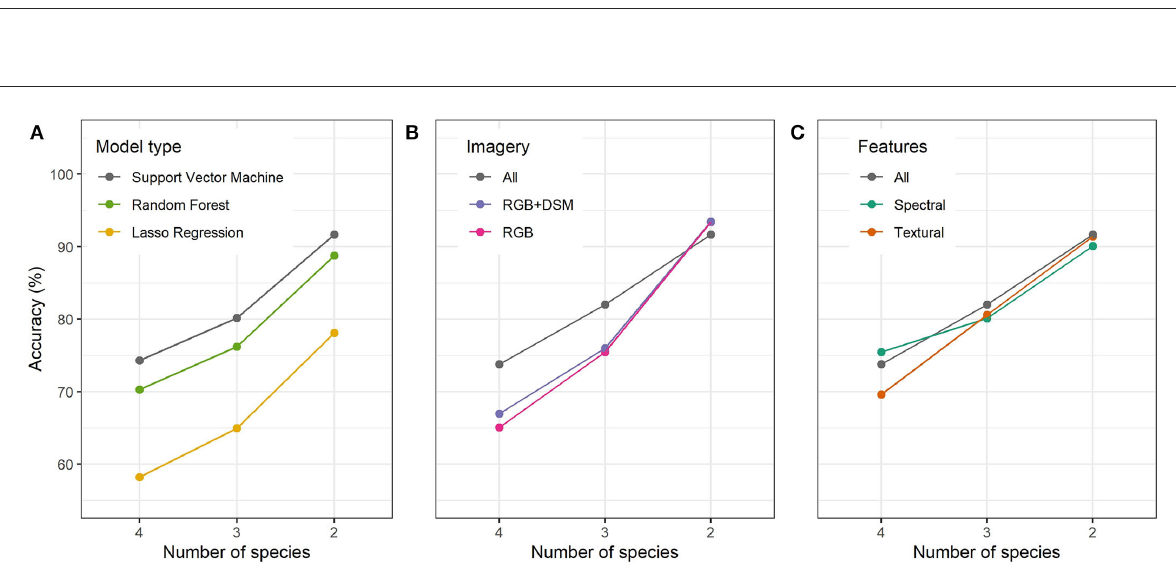
FIGURE7 Accuracy of species classification with (A) model types, (B) imagery used, and (C) features used. Classification accuracy increases with decreasing number of species (x-axes). The two species model classified the early-successional Bellucia pentamera and Macaranga gigantea from an ’other’ class. The three species model additionally classified the long-lived Alstonia scholaris and the four species model also included Endospermum malaccense